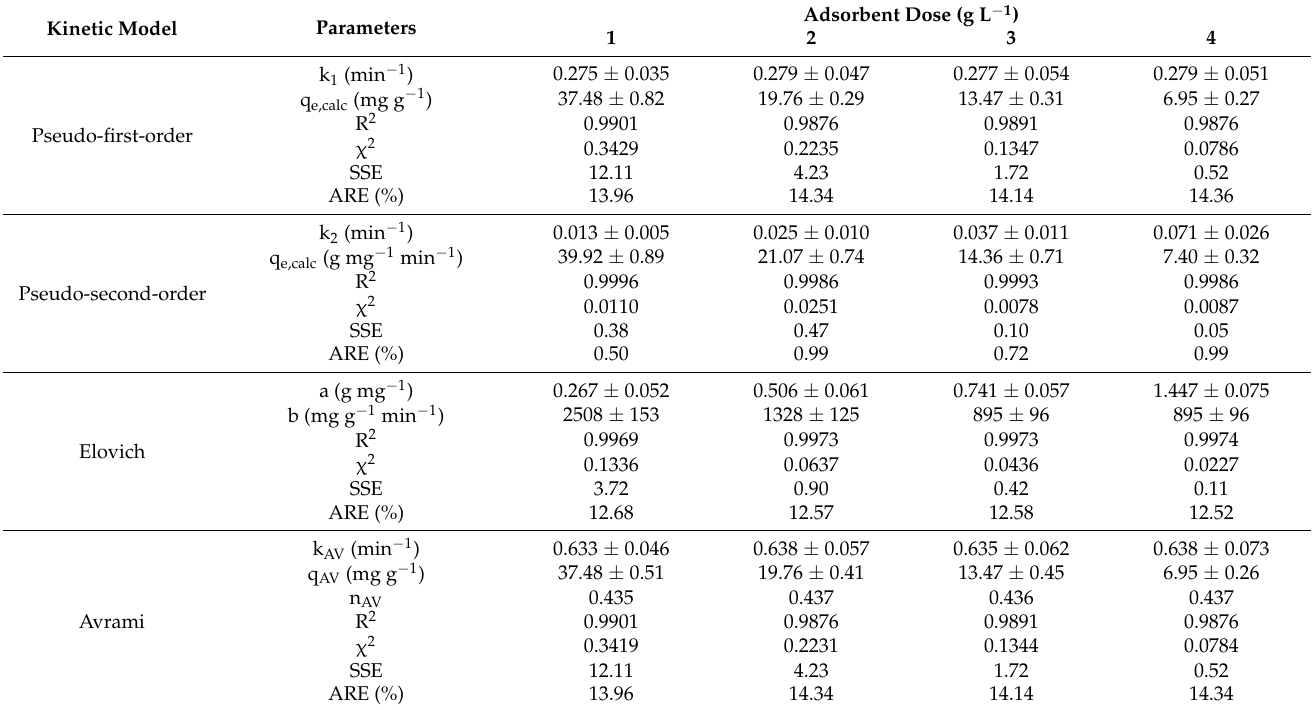
Figure 6. The variation of adsorption capacity with contact time at different doses of adsorbent material (fitted with pseudo-second-order kinetic model). Table 1. The kinetic models’ constants and the corresponding error